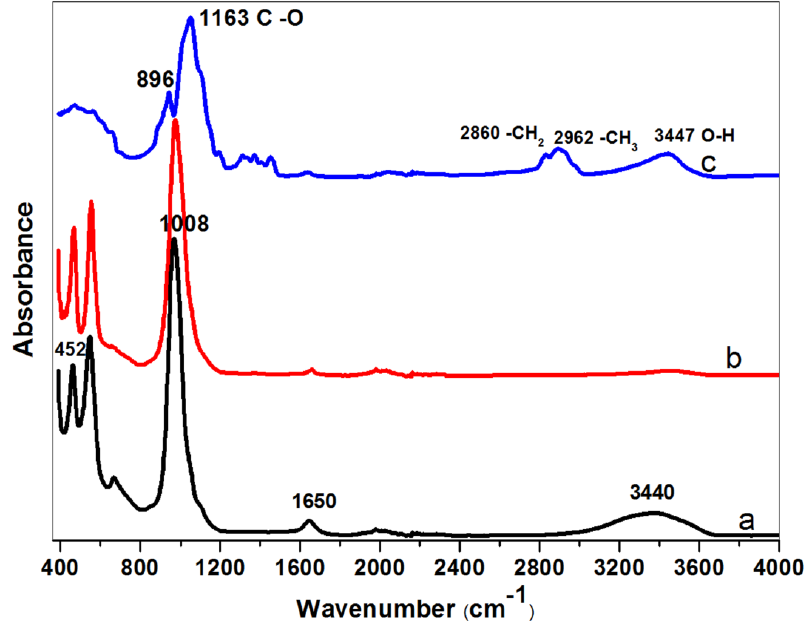
Figure 4. FTIR (Fourier transform infrared) spectra of nanometer-sized NaA samples and MC: methylcellulose removed by (a) simply washing (NZ040); (b) calcination (NZ040); and (c) pure MC.